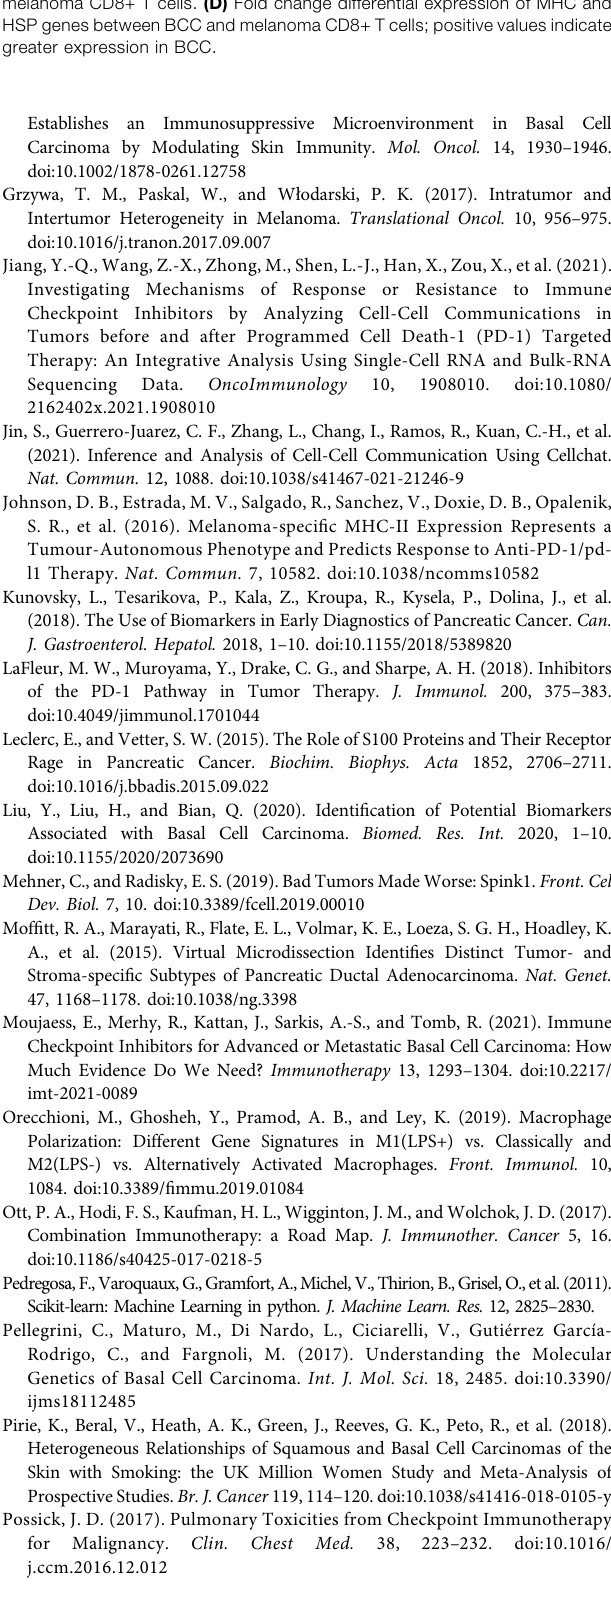
Supplementary Figure S4 | Supervised classi fi cation of CD8+ T cells in BCC and melanoma based on the top n highlyvariable genes. (A, B) ROC and PR curves for classi fi er (architecture described in Methods) trained on the top n highly variable genes in (A) BCC and (B) CD8+ T cells. (C) Comparison of the